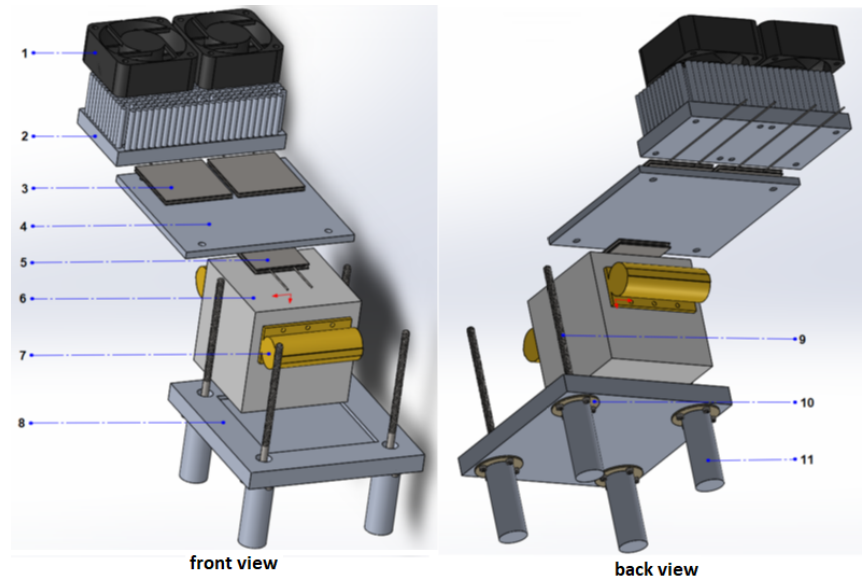
Figure 2. Exploded front and back view of the